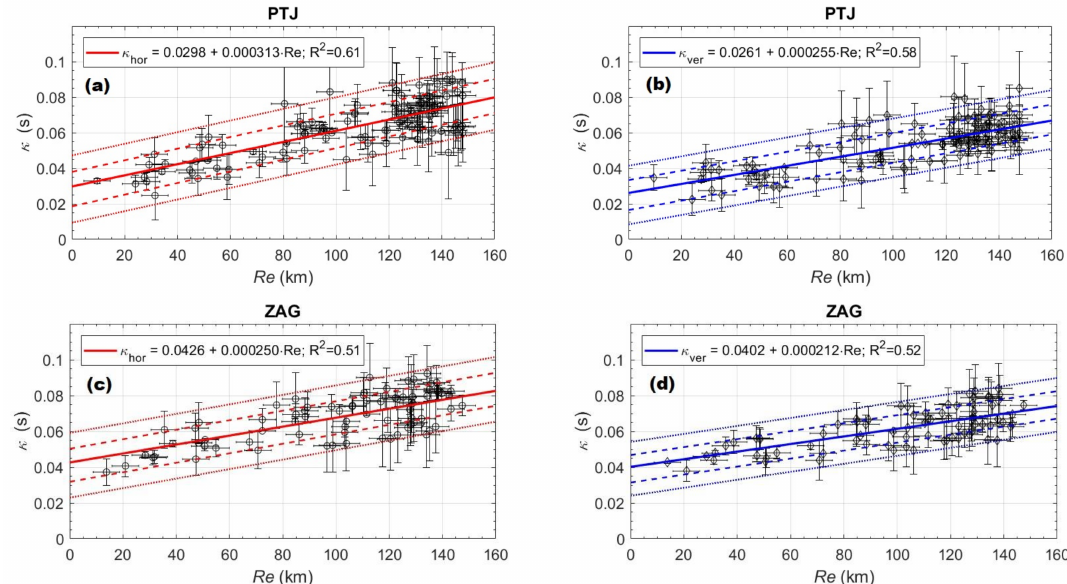
Figure 5. Least-square linear regression of and R e data pairs. PTJ station: ( a ) horizontal model, ( b ) vertical model. ZAG station: ( c ) horizontal model, ( d ) vertical model. Fit regression line shown by thick lines. ± 1 standard deviation-dashed lines. ± 2 standard deviation-dotted lines. Vertical error-bars show the uncertainty of κ values and horizontal error-bars show uncertainty in epicentral distances with standard error set to ± 5